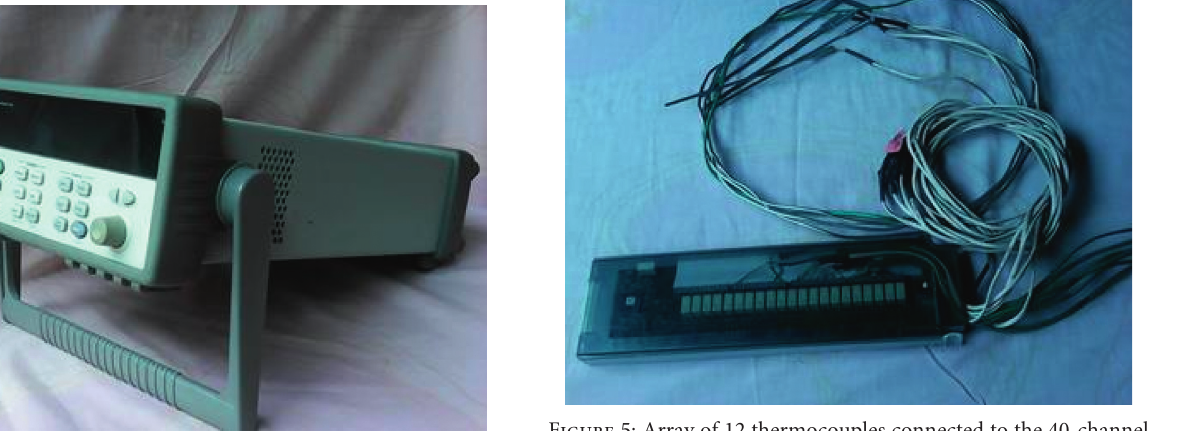
Figure 4: Data acquisition system named Agilent 34970A.